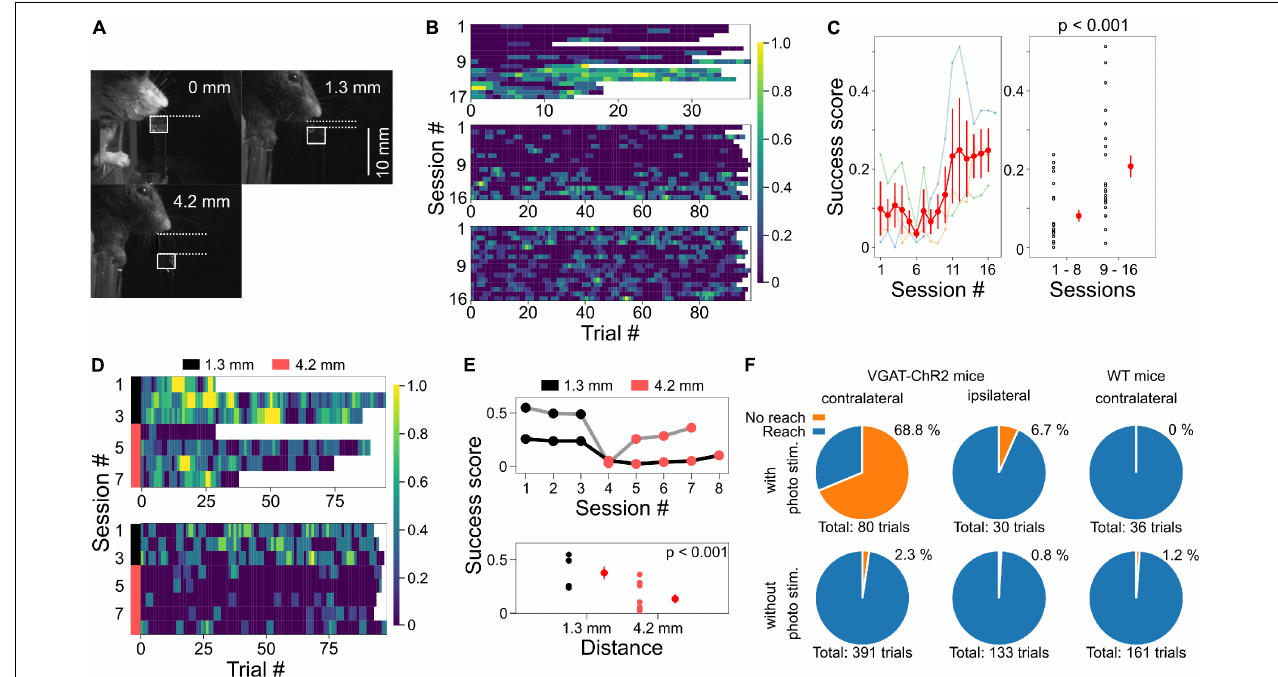
FIGURE 5 | Placing the agar cubes farther away made the task more difficult. (A) Examples of different agar cube positions are shown. In each image, the distance from the jaw of the mouse to the agar top is shown. White squares indicate the position of the agar. (B) Example of changes in success scores in three mice during test sessions when the agar cube was presented at 1.3 mm from the jaw. (C) Left, the relationship between session number and success scores from three mice shown in panel (B) . Data plotted in light color represent data from individual mice. Red plots and error bars represent mean and standard error, respectively. Right, Success scores in the second half of the session increased compared to the first half ( p < 0.001, one-way ANOVA). (D) Success scores are shown in color plots when the distance from the mouse jaw to the ager was changed from 1.3 to 4.2 mm. Data obtained from two mice are shown. The black and pink bar lines indicate sessions in which the agars were located at 1.3 and 4.2 mm, respectively. (E) Top, from the data in panel (D) , the relationship between session number and mean success score are shown. Gray and black lines indicate data from two different mice. Bottom, success scores decreased when the agar cube was placed at 4.2 mm compared to the condition with the agar cube placed at 1.3 mm ( p < 0.001, one-way ANOVA). (F) The reaching movements depend on M1 activity. Left, reaching was suppressed by the photostimulation to M1 on the left (contralateral) side of VGAT-ChR2 mice; with photostim.: 55/80 trials (68.8%), without photostim.: 9/391 trials (2.3%), 2 mice, p < 0.001, Chi-square test. Middle, reaching was not suppressed by the photostimulation of M1 on the right (ipsilateral) side; with photostim.: 2/30 trials (6.7%), without photostim.: 1/133 trials (0.8%). Right, reaching was not suppressed by the photostimulation of M1 on the left (contralateral) side